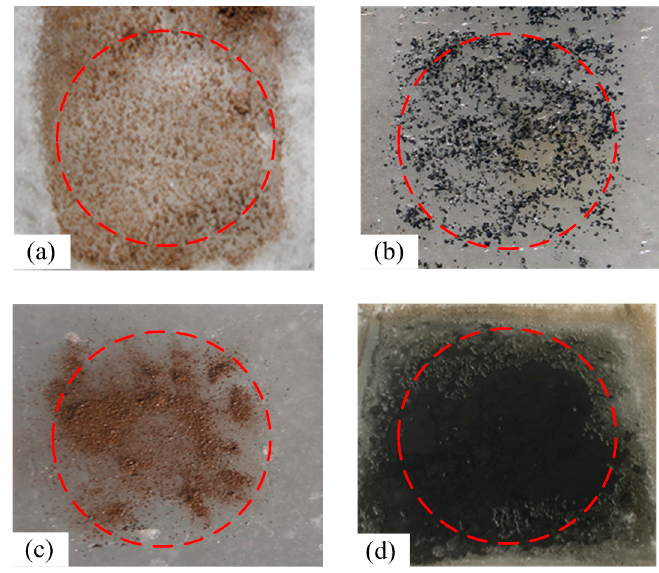
Figure 2. Schematic of the false targets. Sea ice covered by sediment ( a ); coal dust ( b ); and iron ore fines ( c ). The ice was melted, resulting in a dark melt pool ( d ).